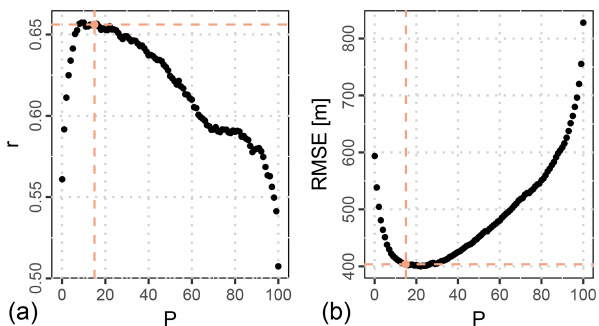
Figure 6. Evaluation of the percentile P which is applied to retrieve z base from the distribution of z for the year 2008, with N = 10 and R c = 10km. (a) The linear correlation coefficient r between z base and ˆ z base . (b) The RMSE between z base and ˆ z base . The chosen value for P is highlighted in